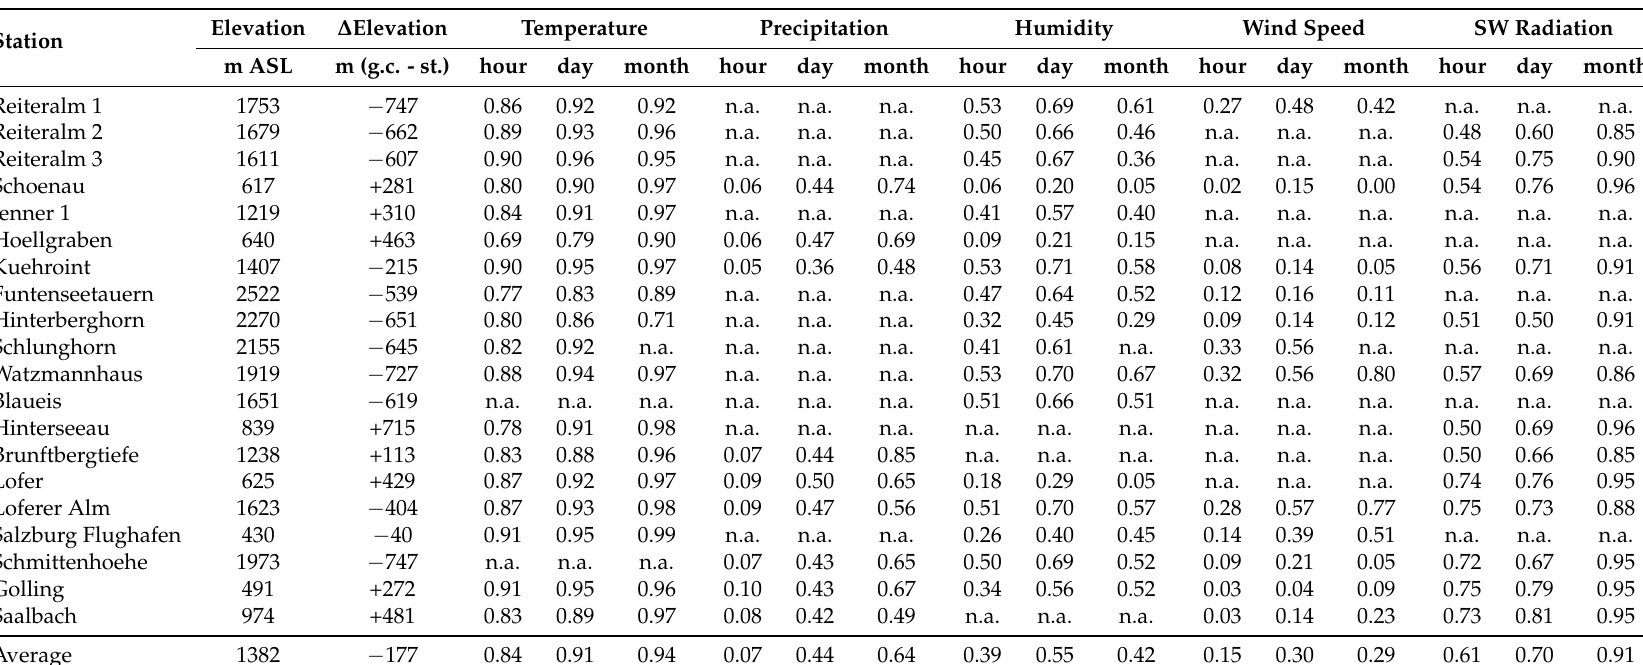
Table 1. R 2 values for WRF (ERA-Interim) results against station data for the period 2001–2009 and the variables temperature, precipitation, humidity, wind speed, and short-wave radiation (hourly, daily, and monthly, g.c. = grid cell, st. = station, n.a. = not